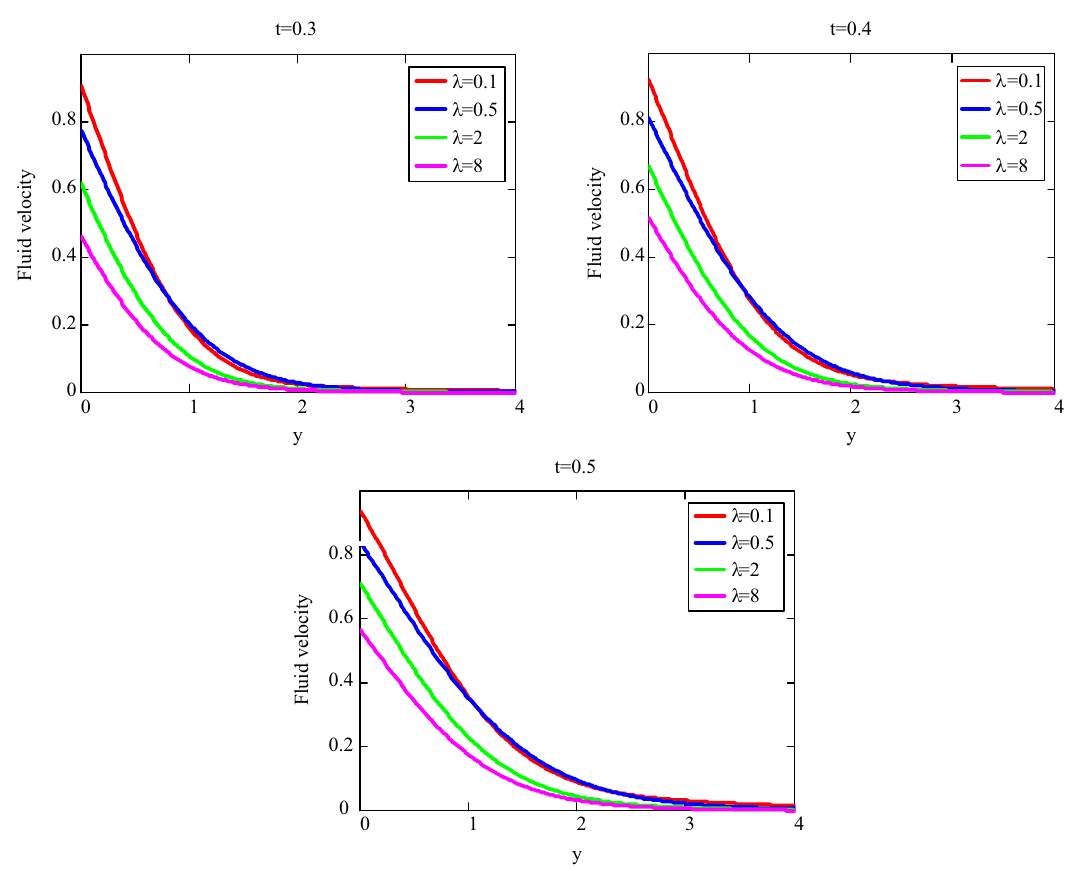
Figure 4: The velocity pro fi le for the variants of relaxation time at di ff erent